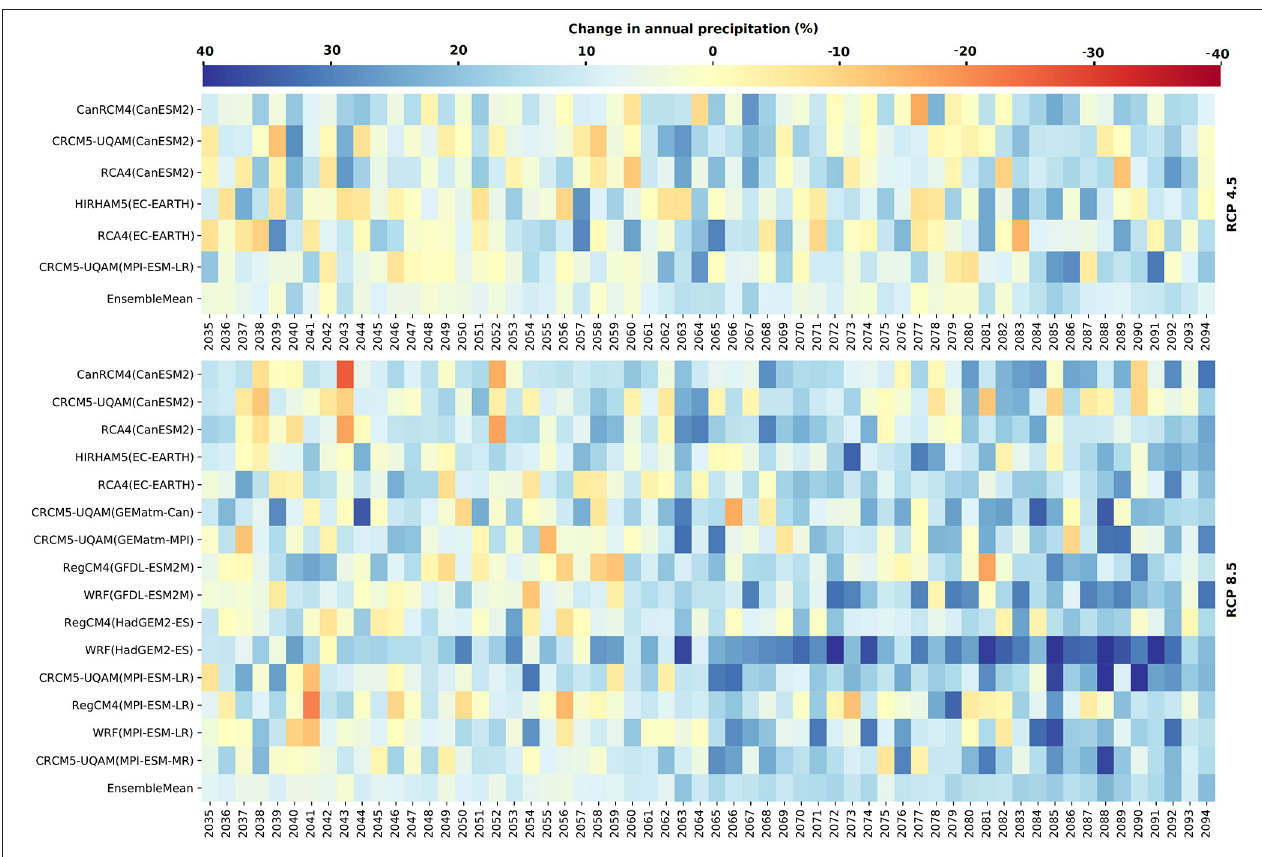
FIGURE 4 | Change in annual over-land precipitation with respect to baseline average precipitation for RCP4.5 and RCP8.5 scenarios in mid- and end-century periods.